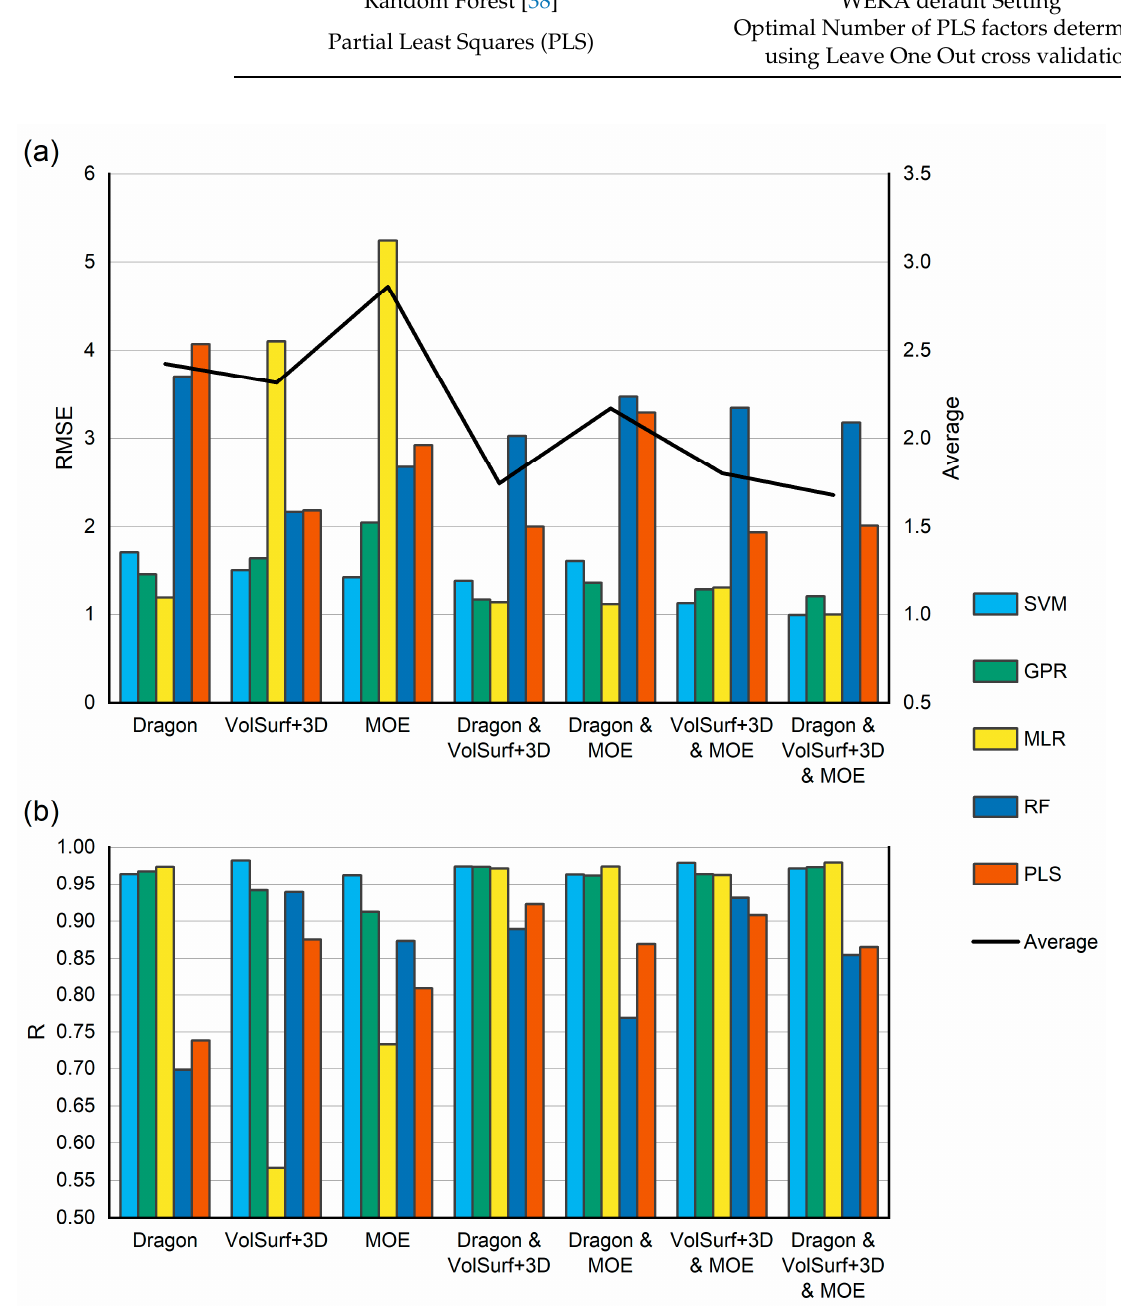
Figure 2. Comparison of Root Mean Square Error (RMSE) ( a ) and Correlation Coefficient (R) ( b ). For all calculated descriptors, their combinations and all regression algorithms. Each bar corresponds to the average value for all training sets. Figure 2a also contains average value for all applied algorithms. SVM: Support vector machine; GPR: Gaussian processes regression; MLR: multiple linear regression; RF: random forest; PLS: partial least